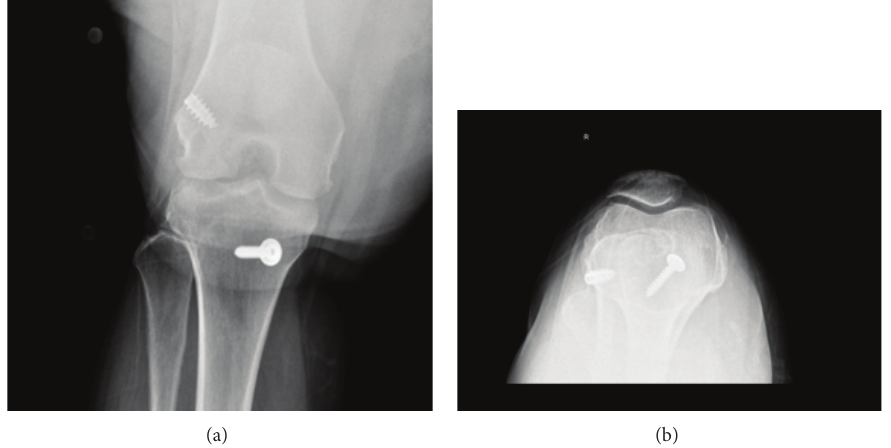
Figure 2: (a) Anteroposterior (AP) and (b) sunrise view of the right knee in a 39-year-old female patient who underwent ACL reconstruction with medial meniscectomy at the age of 33 after sustaining an ACL tear with concomitant medial meniscus and MCL tears. These radiographs demonstrate joint space narrowing, particularly in the medial and patellofemoral compartments, consistent with early osteoarthritic changes.